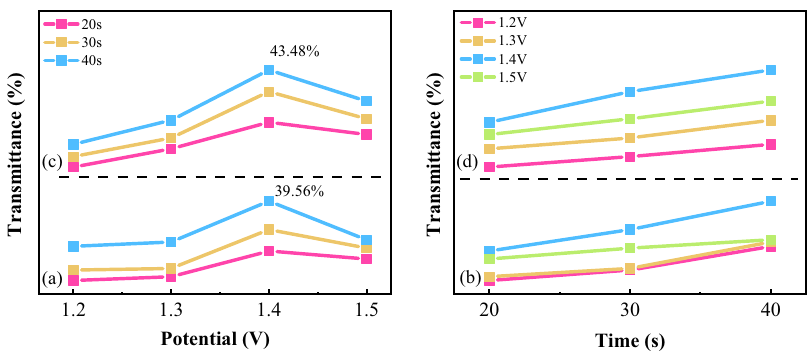
Figure 6: Optical transmittance of ( a ) PEDOT:PSS fi lms deposited at di ff erent voltages for a de fi nite time, ( b ) PEDOT:PSS fi lms deposited at a de fi nite voltage for di ff erent times, ( c ) PEDOT:PSS/EMI - TFSI fi lms deposited at di ff erent voltages for a de fi nite time, and ( d ) PEDOT:PSS/EMI - TFSI fi lms deposited at a de fi nite voltage for di ff erent times.